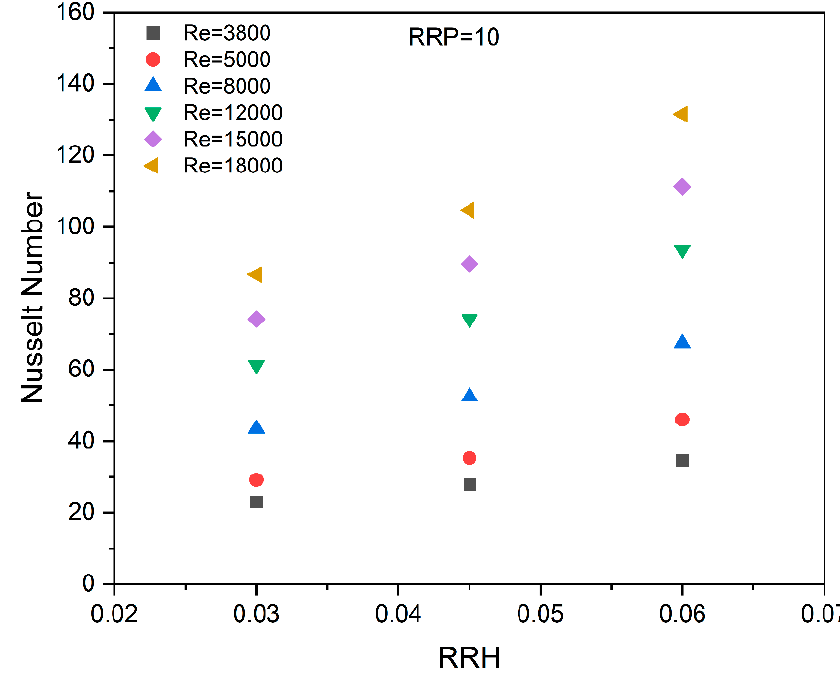
Figure 15. Nu r versus RRH .